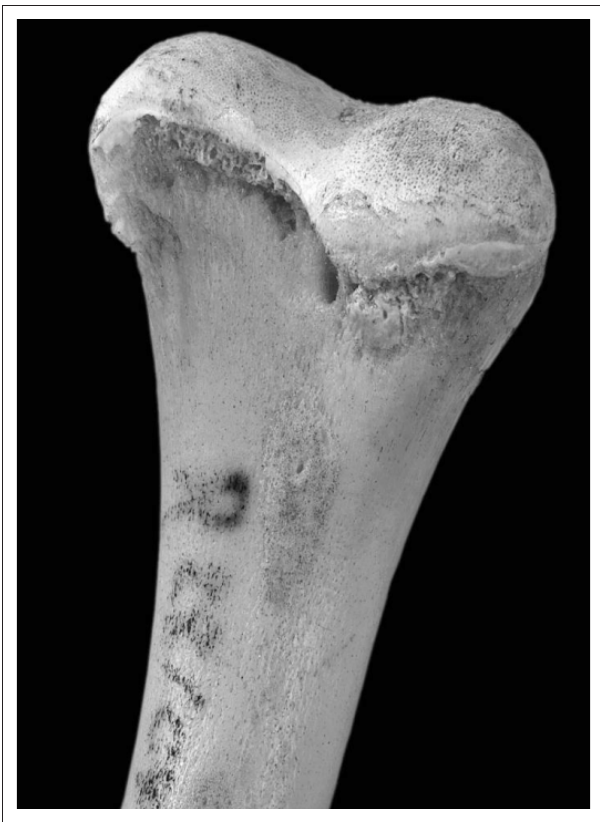
FIGURE 5: Humerus of a wild adult Nile crocodile, case 3: Loss of cortical substance around the caput humeri and partial collapse of the articular surface.